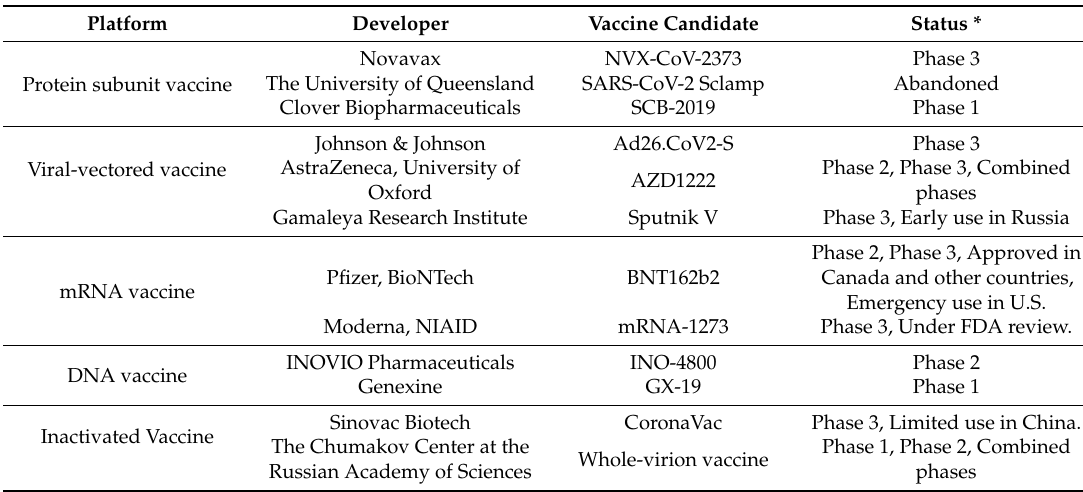
Table 2. Overview of Selected COVID-19 Vaccine